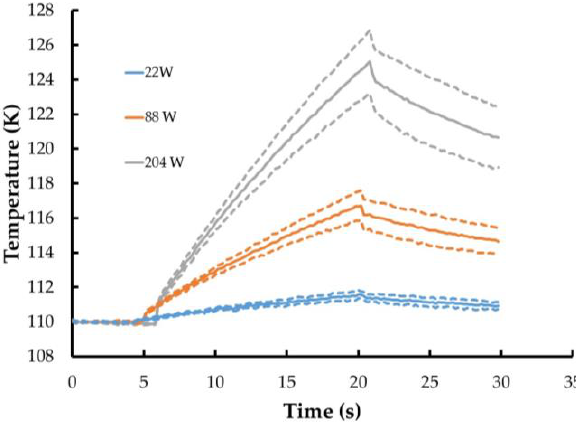
Figure 7. Temperature measured using TSP and CNT heater layer at 110 K.